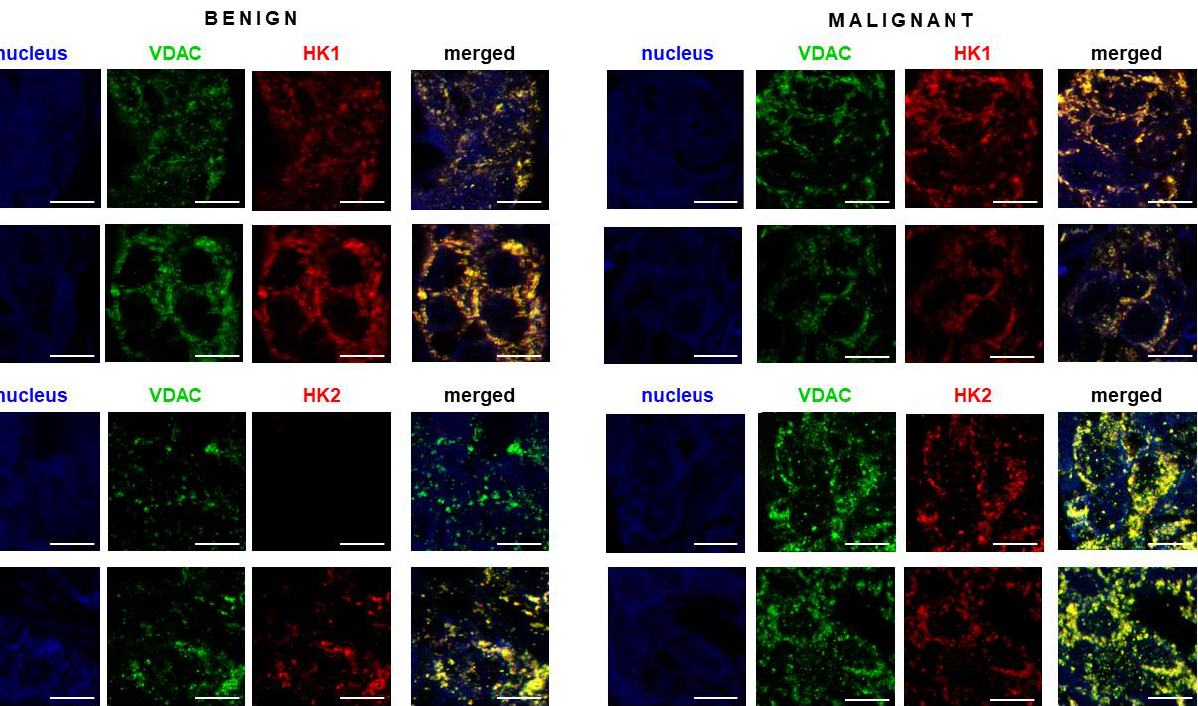
Figure 5. Hexokinase 2 colocalization with mitochondrial marker VDAC in premenopausal breast cancer. Immunofluorescence staining and confocal microscopy images showing voltage-dependent anion-selective channel protein 1 (VDAC)/hexokinase 1 (HK 1) and VDAC/hexokinase 2 (HK 2) protein localization in benign and malignant breast tumor tissue of normal-weight and overweight/obese premenopausal women. Double immunolabeling is shown in separate channel micrographs against VDAC (green), HKs (red), and as merged channels showing colocalization of VDAC and HKs (yellow). Nuclei were stained with Sytox Orange (false blue). Magnification: ×63, Zoom: ×2. Scale bars: 10 µm.